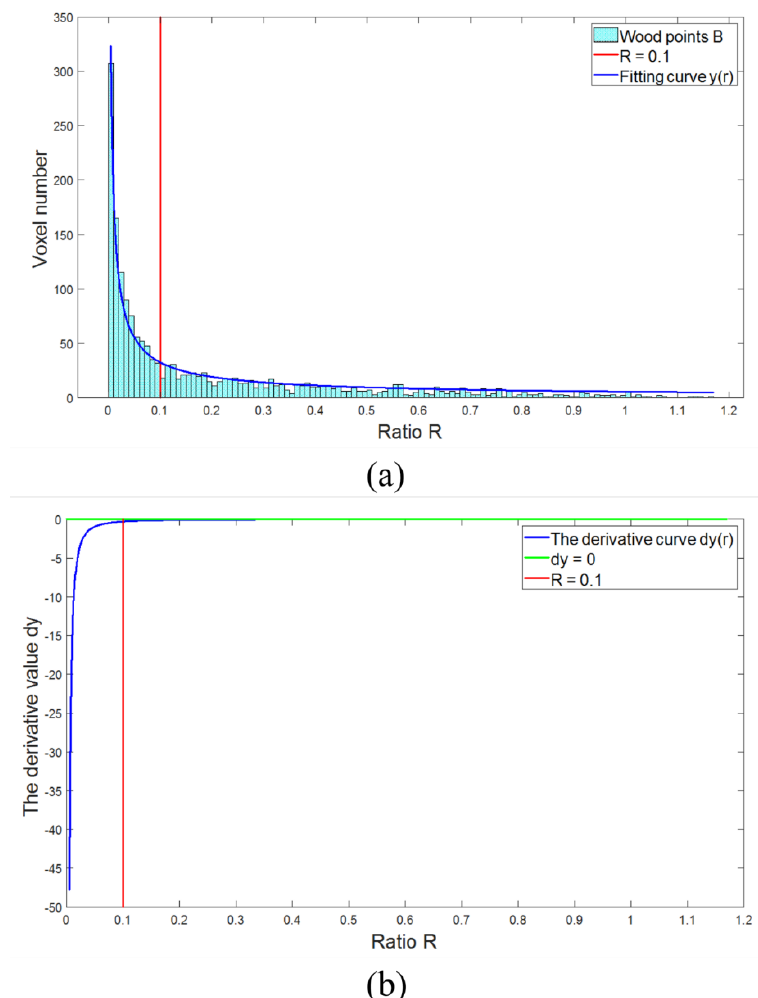
Figure 9. Demonstration of the threshold of voxel ratios. ( a ) Cyan areas represent the ratio histogram of all voxels of wood points B, the blue line is the fitting curve of histogram, and the red line is ratio R = 1. ( b ) The blue line is the derivative curve of the fitting curve, the green line means the derivative is 0, and the red line is ratio R = 1.